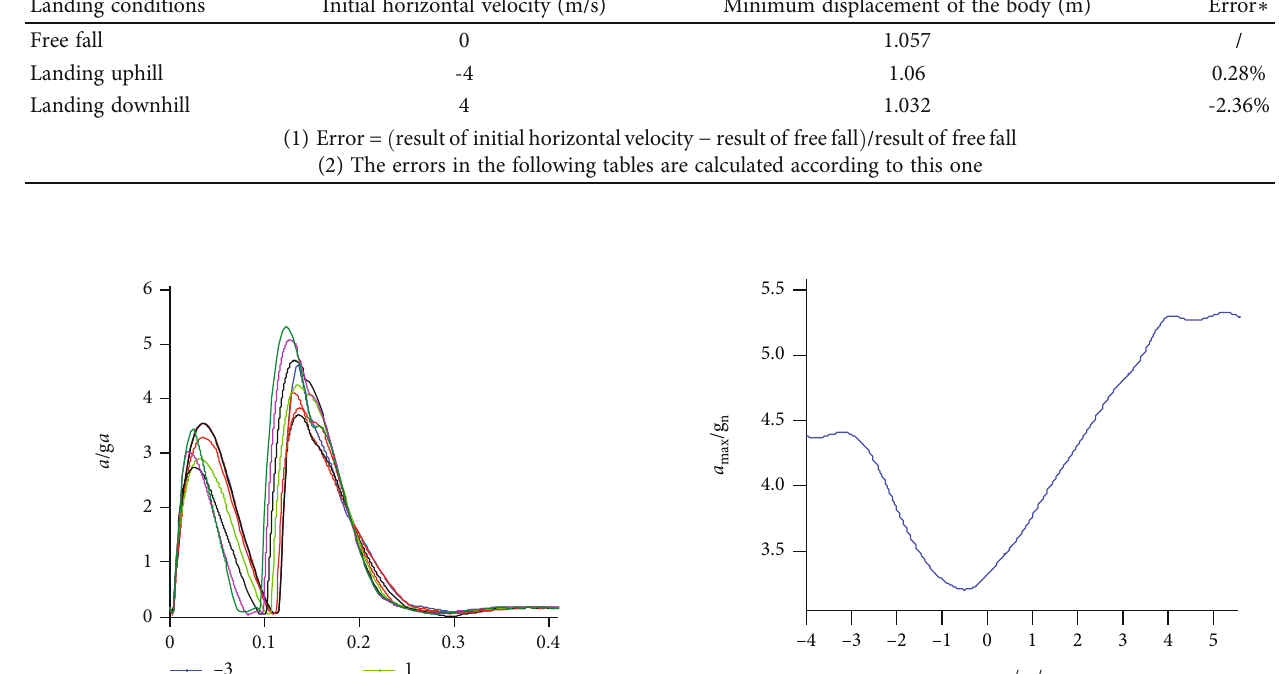
Table 3: Impact of typical working conditions of initial horizontal velocity on the minimum displacement of the body. Landing